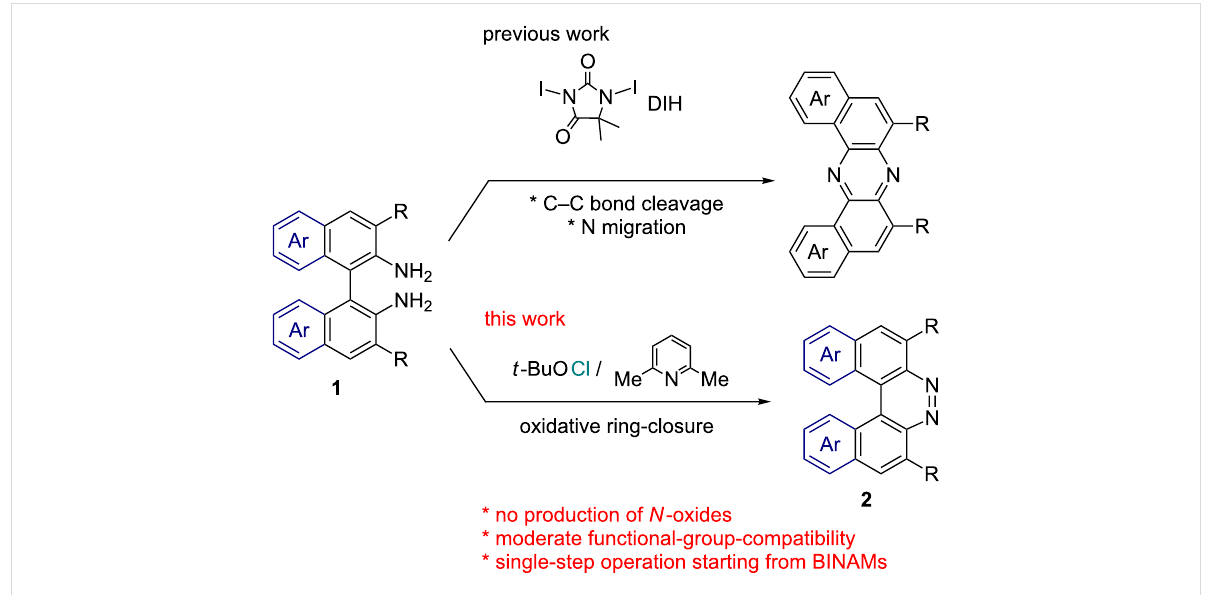
Scheme 2: Oxidant-controlled transformations of